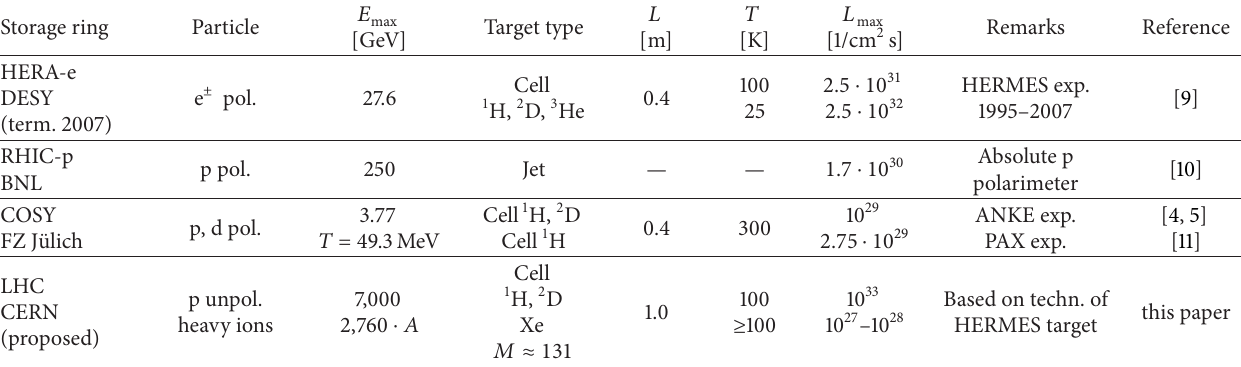
Table 1: Comparison of gas targets in storage rings with a hypothetical target for the proposed AFTER@LHC initiative [1, 2].The target gas 1 H, 2 D, or 3 He is assumed to be spin